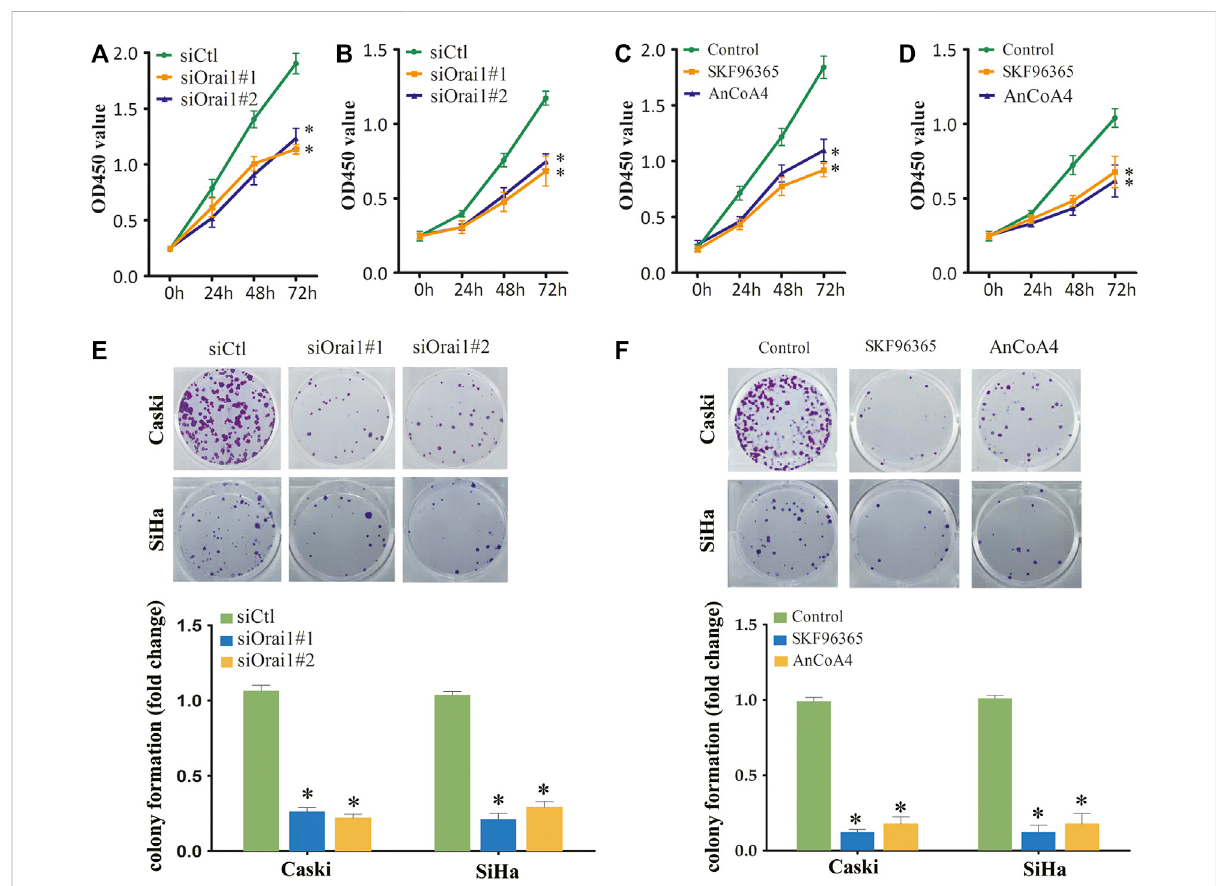
FIGURE 3 Inhibition of Orai1 and SOCE inhibited the growth of cervical cancer cells (A,B) Viability of Caski (A) and SiHa (B) cells transfected with siCtl or siOrai1. (C,D) ViabilityofCaski (C) andSiHa (D) cellspre-treatedwith10 μ MSKF96365or10 μ MAnCoA4. (E) NumberofcoloniesformedbyCaskiand SiHa cells transfected with siCtl or siOrai1. (F) Number of colonies formed by Caski and SiHa cells pre-treated with 10 μ M SKF96365 or 10 μ M AnCoA4. Values are means ± SEM, * p < 0.05 compared to si-Ctl or control